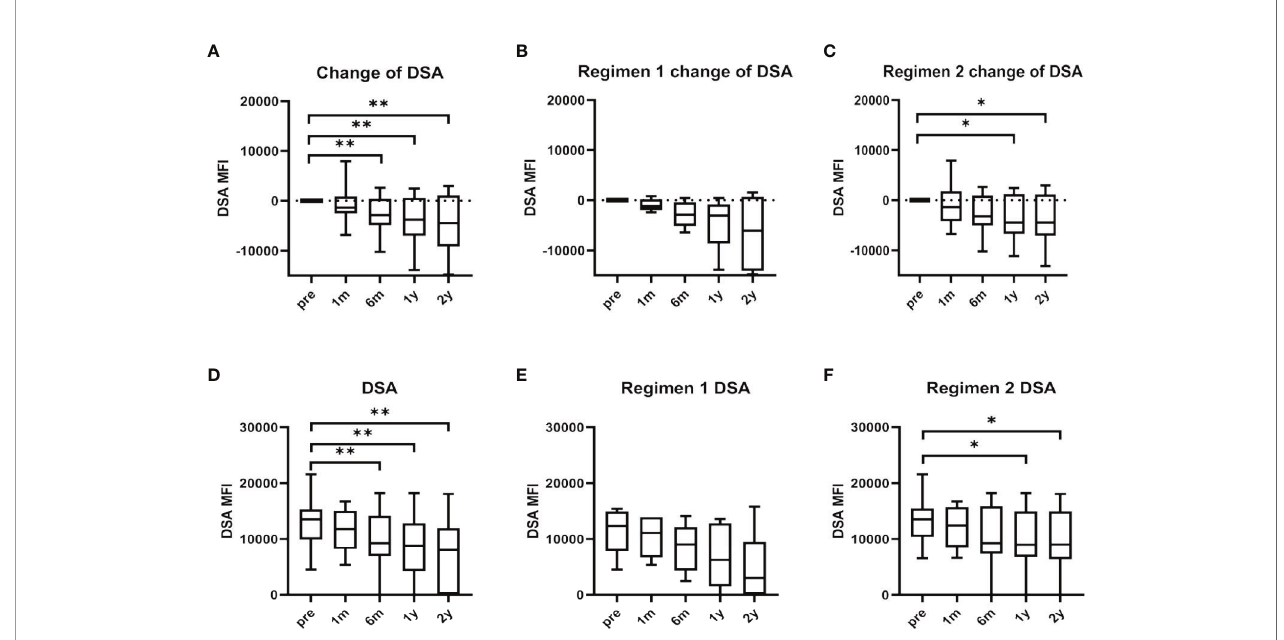
FIGURE 2 | Maximum donor-speci fi c antibody (maxDSA) value pre and after BM-MSCs treatment. Change of maxDSA MFI pre and after BM-MSCs treatment in total BM-MSCs treated (A) , Regimen 1 (B) , and Regimen 2 populations (C) . MaxDSA MFI pre and after BM-MSCs treatment in total BM-MSCs treated (D) , Regimen 1 population (E) , and Regimen 2 population (F) during the study period. Boxplots represent the lower quartile, median and upper quartile. Bars represent minimum and maximum. Data were analyzed by Wilcoxon test. *p < 0.05, **p < 0.01.